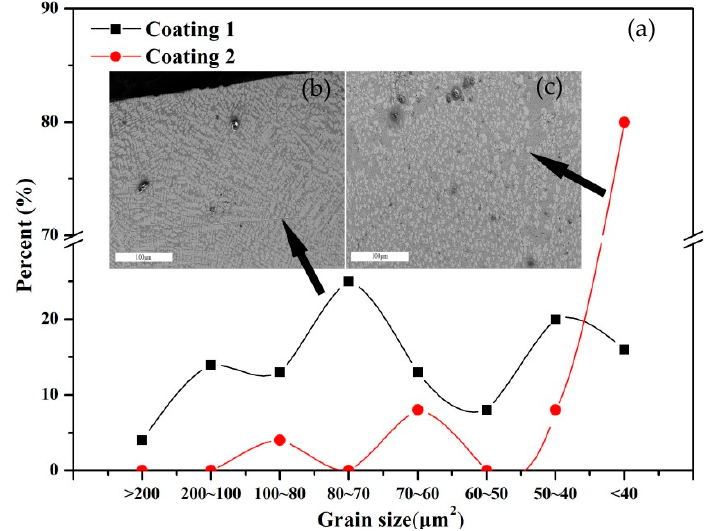
Figure 11. ( a ) The particle size distribution of α -Fe cellular crystals in Coating 1 and (Cr, Fe) 7 C 3 blocks in Coating 2, ( b ) α -Fe cellular crystals in Coating 1 and ( c ) (Cr, Fe) 7 C 3 blocks in Coating 2.